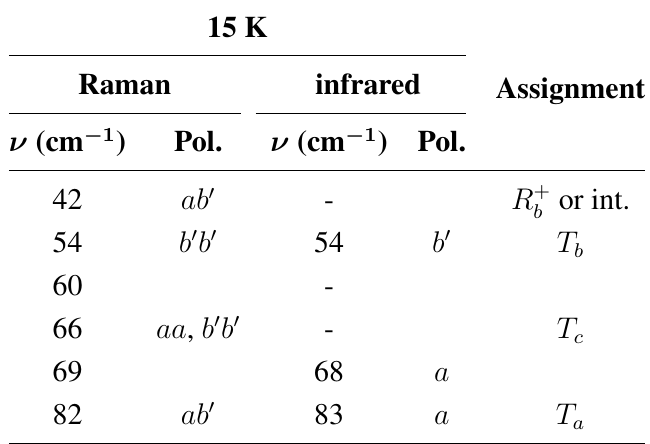
PF lattice modes 2 6